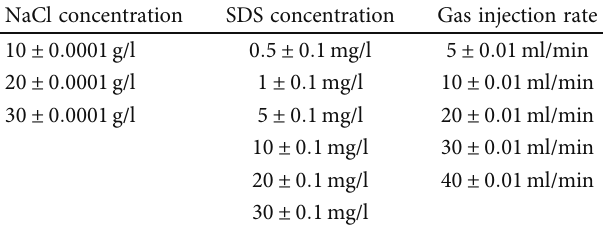
Table 1: The selection of the solute concentrations of sodium chloride (NaCl) and sodium dodecyl sulphate (SDS) surfactant (CH ) SO Na) and the gas injection rates for each water (CH 3 2 11 4 solution. NaCl concentration SDS concentration